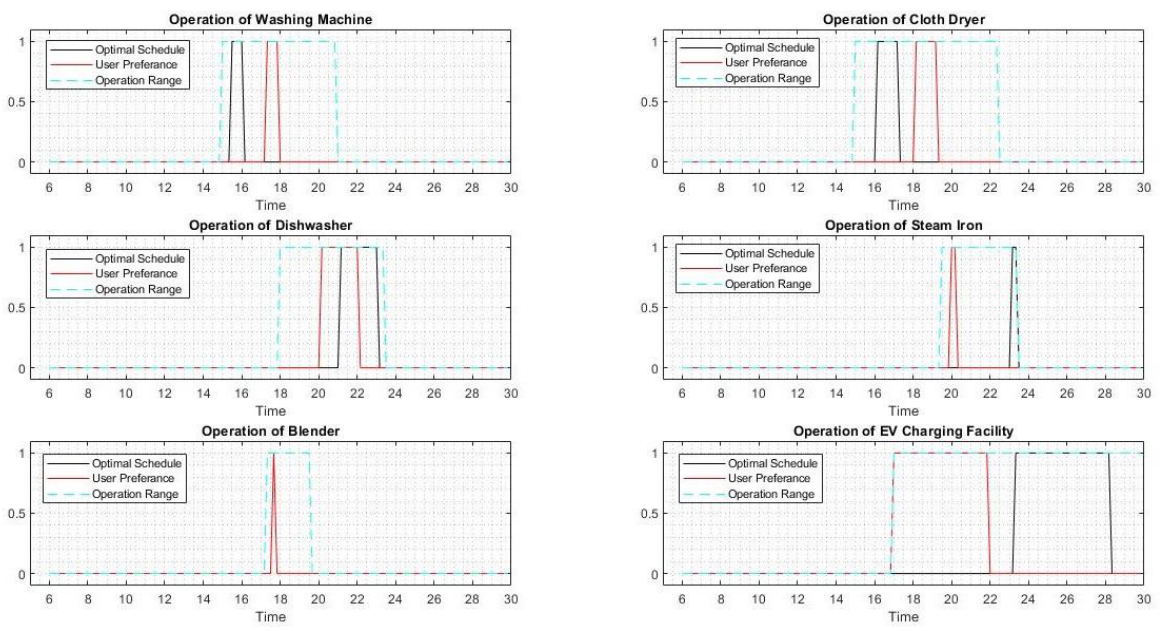
Figure 4. The operation of some assets in one of the residential buildings in the case where they did not collaborate.